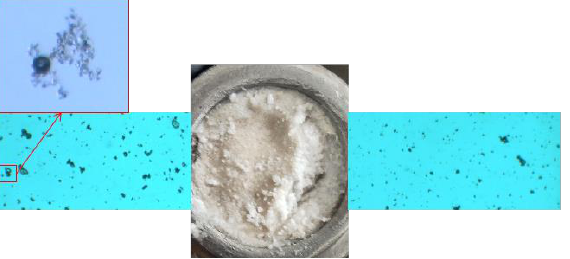
Figure 14. Micrograph of pore formation model’s end face and internal after injecting PEG system.